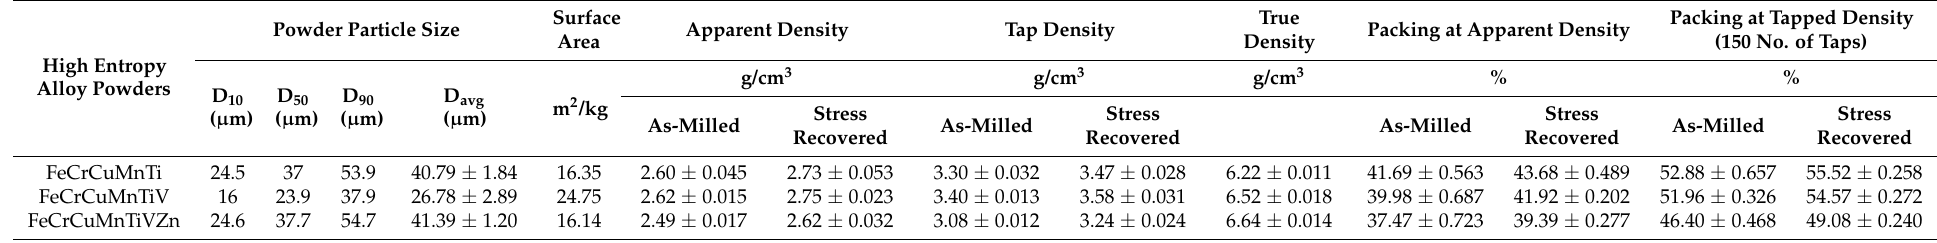
Table 3. Powder particle size, surface area, apparent density, tap density, packing at apparent density, and packing at a tapped density of three developed high entropy alloy powders.